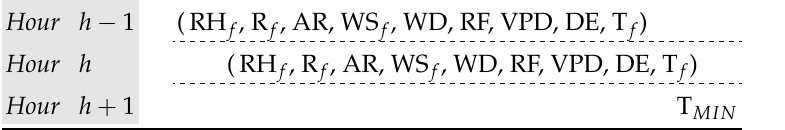
Table 3. Attributes that define a final instance in the dataset. This instance captures the temporal relationship between three consecutive hours.